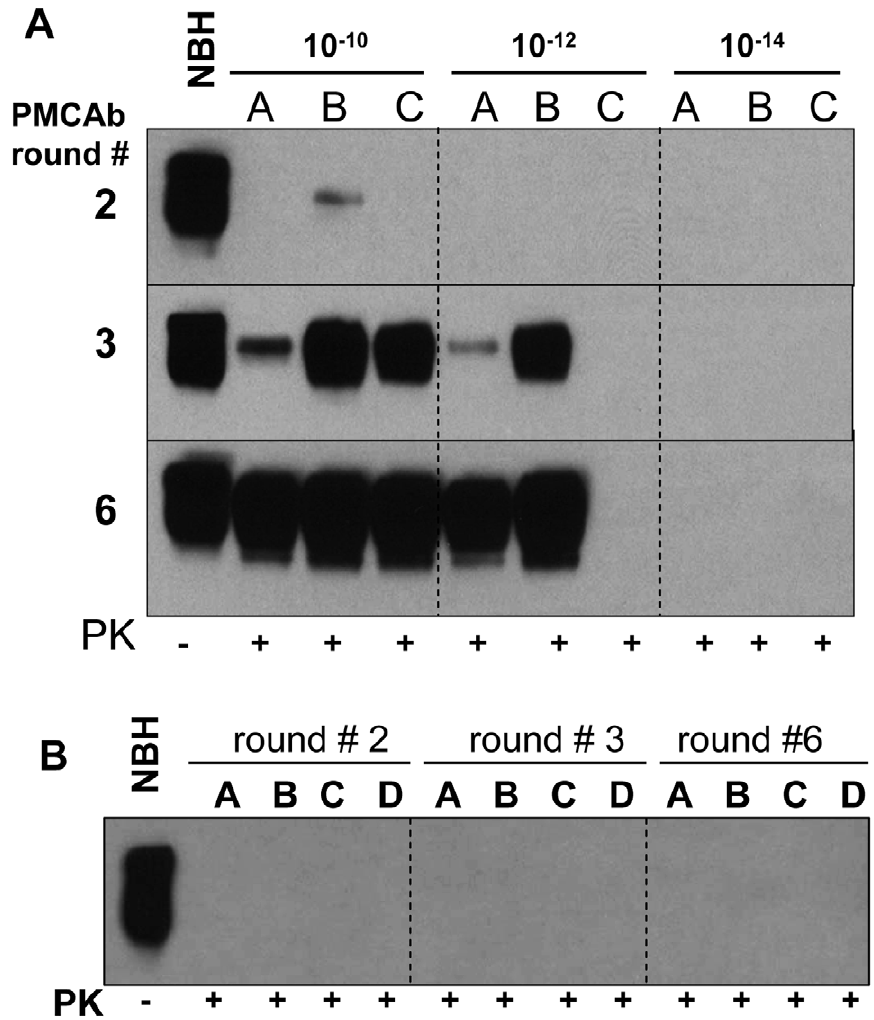
Figure 4. Amplification of minute amounts of PrP Sc in PMCAb. ( A ) 263K brain material was serially diluted 10 10 -, 10 12 -, or 10 14 -fold and subjected to sPMCAb amplification in the presence of 3 large beads for 6 rounds as indicated (each round consists of 48 sonication cycles, 10-fold dilutions were used for subsequent rounds). Amplification in three independent experiments (A, B, and C) are shown. ( B ) Up to six rounds of PMCAb in non-seeded NBHs (reactions A and B) or in NBHs seeded with 10 m l of 10% NBH prepared from 661 days old Syrian Hamsters (reactions C and D) were performed as negative controls. Undigested 10% NBH is provided as a reference.